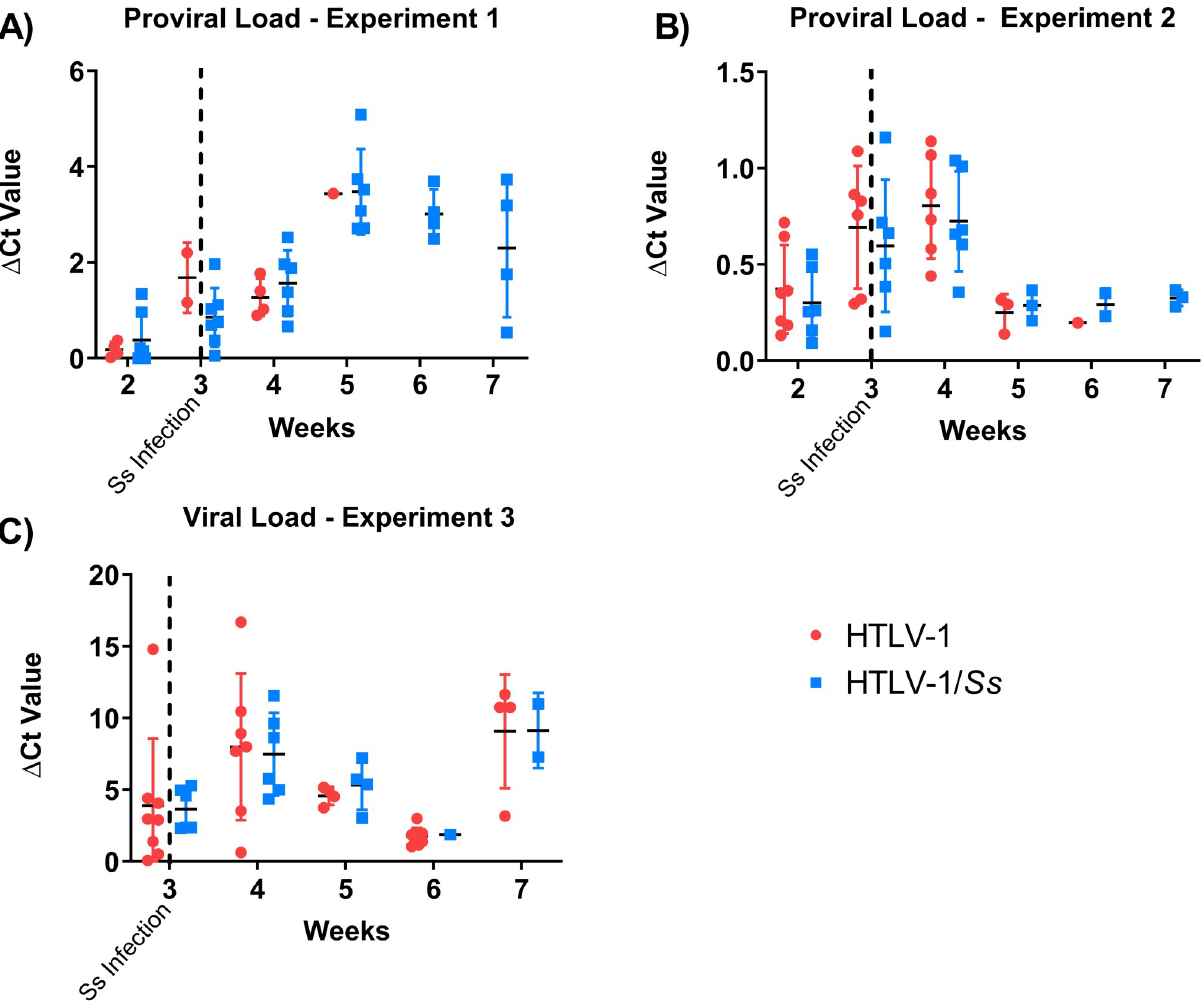
Fig 4. Proviral and viral load levels in humanized NSG mice during infection with HTLV-1 and Strongyloides stercoralis (Ss) . Proviral loads in white blood cells were determined using real-time PCR with primers and probes specific for the HTLV-1 pX region. The HTLV-1 total RNA levels in the white blood cells were determined using real-time PCR. Results for proviral load measurements from two independent experiments are presented (A & B) and viral RNA levels from one experiment (C). No significant difference was observed between HTLV-1 infected and coinfected animals. The vertical dotted line represents time of S . stercoralis infection with 5,000 third stage